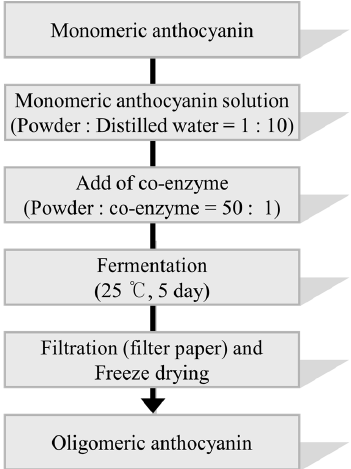
Figure 2. The flow chart for the synthesis of oligomeric anthocyanins using crude enzyme from Aspergillus niger .